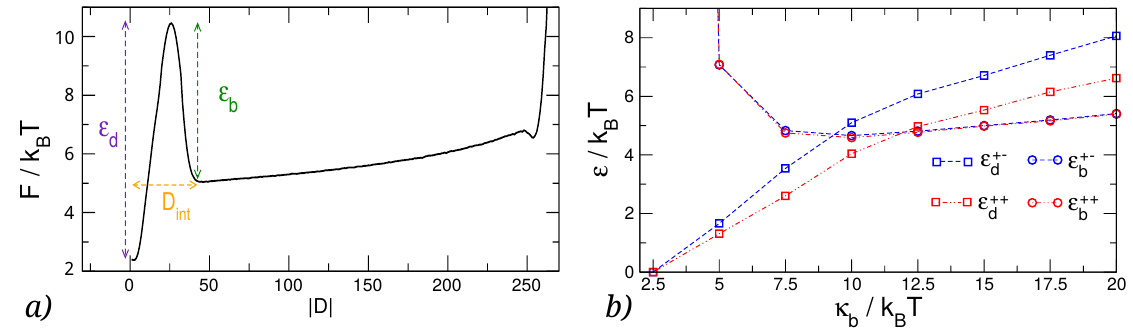
Figure 5. ( a ) Graphical representation of three quantities discussed in the text: the height of the barrier, (cid:101) b , the depth of the minimum, (cid:101) d , and the interaction distance, D int ; ( b ) Dependence of the height of the barrier and the depth of the free energy minimum on the polymer bending rigidity, κ b